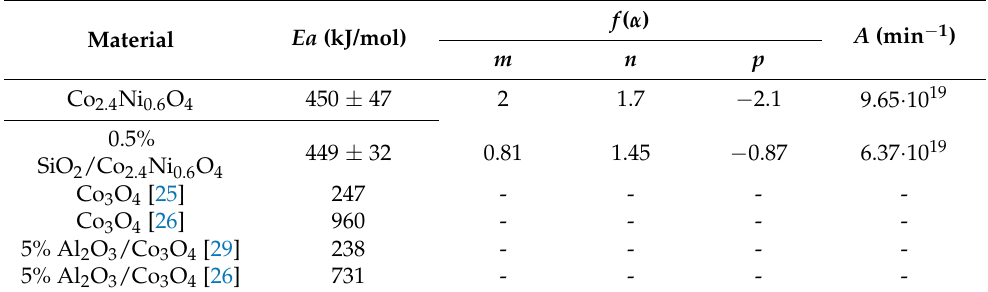
Kinetic triplet values describing the reduction reaction of the Co 2.4 Ni 0.6 O 4